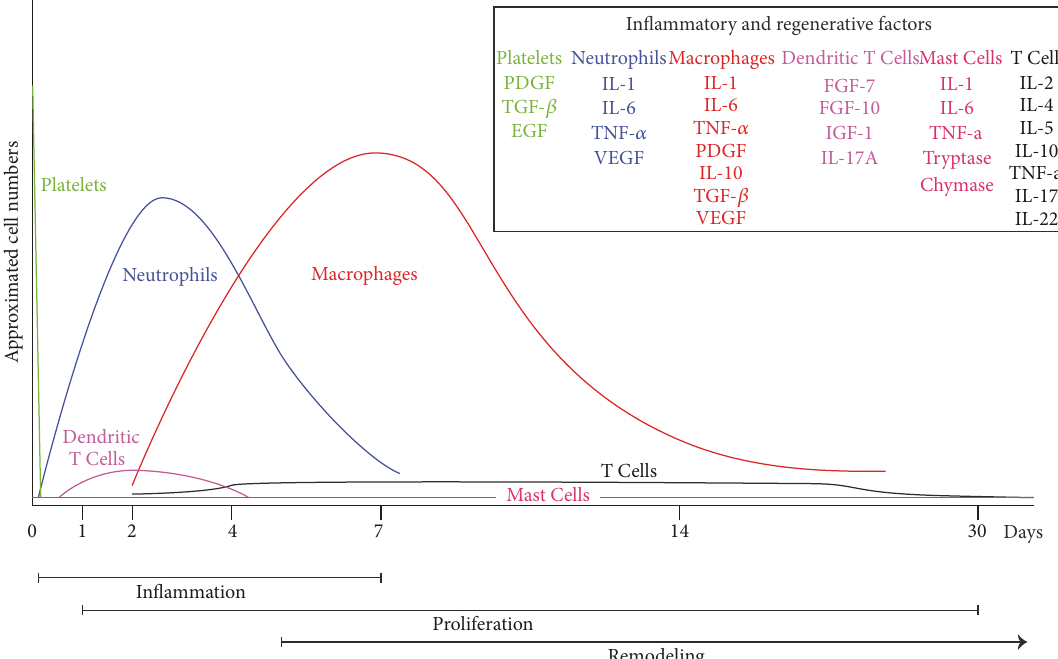
Figure 2: Neutrophil accumulation in the wound increases during the initial inflammatory phase and starts declining 4 days later until the end of the week [49]. Macrophages increase their numbers during the inflammation phase, reach maximum concentration during the proliferation phase, and decline progressively during the remodeling phase, being the most abundant cell in all phases of wound repair [63, 115]. Lymphocytes start increasing their number after injury and reach a plateau at day 4 that continues to be present until the last phase. The skin resident cell number in dendritic cells, mast cells, Trm, and Treg rm is not known, but the presence in the skin of a large population of T memory cells protects the skin against reinfection [99]; further research will be required to clarify their functions in the wound healing process. The approximated time of each of the wound healing phases is illustrated in the bars at the bottom of the graphic